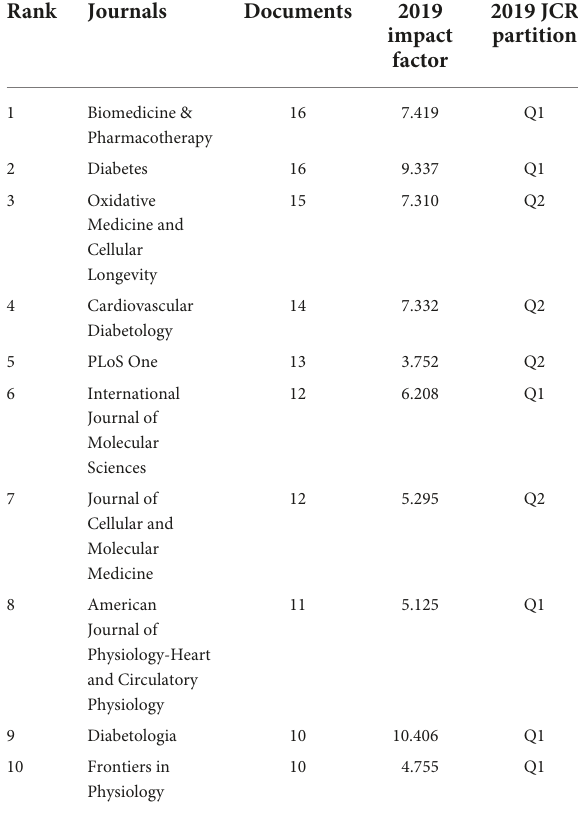
TABLE 2 Top 10 journals with the largest number of publications on inflammation in